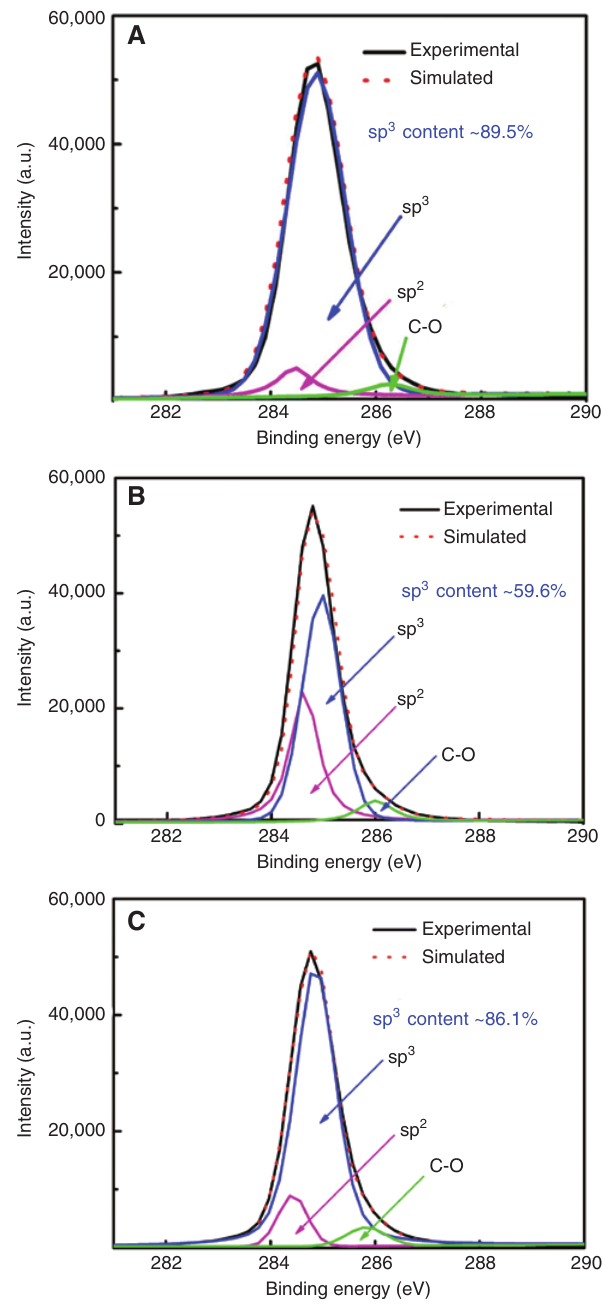
Figure 8: High-resolution XPS spectra diamond film samples at various gas flow rates (sccm). (A) O Ar-14.